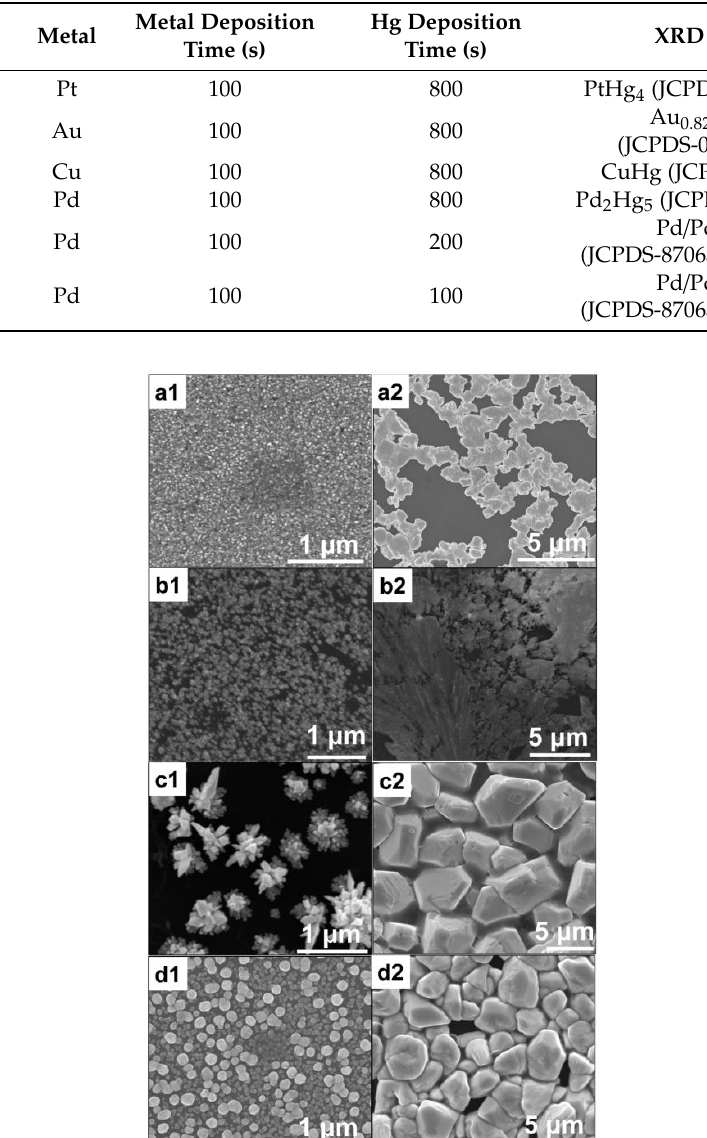
Table 1. Preparation of metal amalgam electrodes on the glassy carbon.